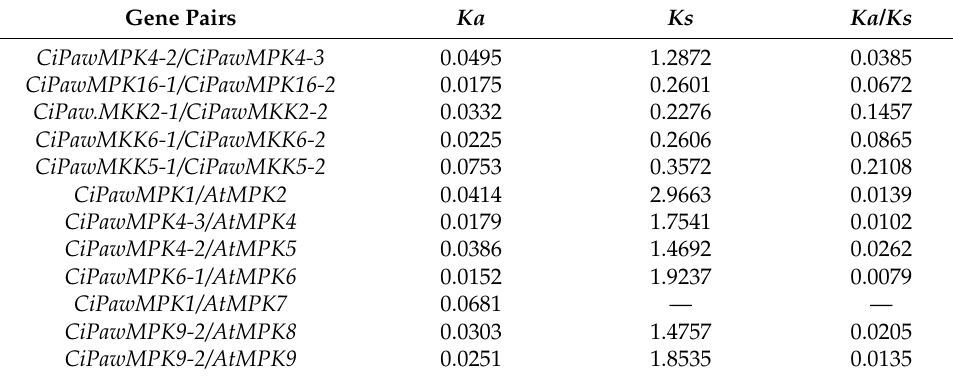
Figure 6. Analysis of duplication of MPK and MKK genes. Co-linear relationships between rice and pecan are shown as green arcs, between Arabidopsis and pecan as orange arcs, and between pecan itself as purple arcs. Table 1. The Ka , Ks and Ka/Ks values of the collinear gene pairs of MPK and MKK in pecan, rice, and Arabidopsis .